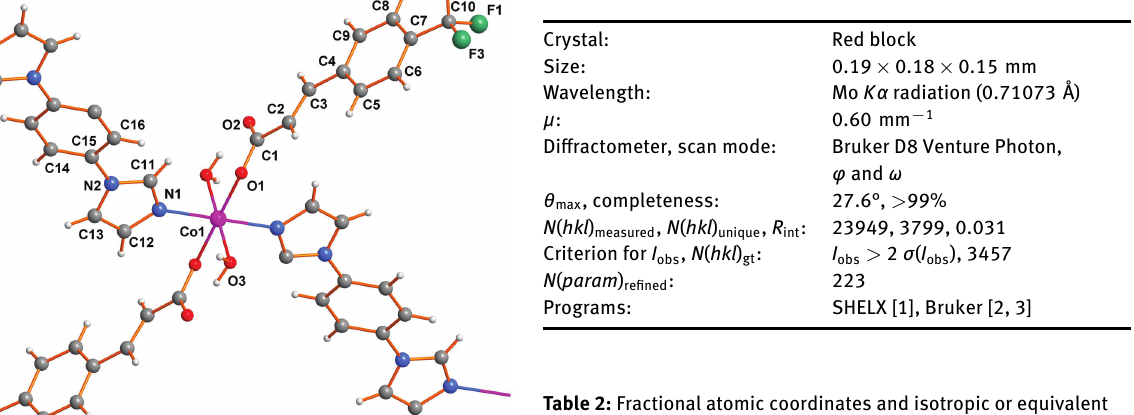
Table 2: Fractional atomic coordinates and isotropic or equivalent isotropic displacement parameters (Å 2